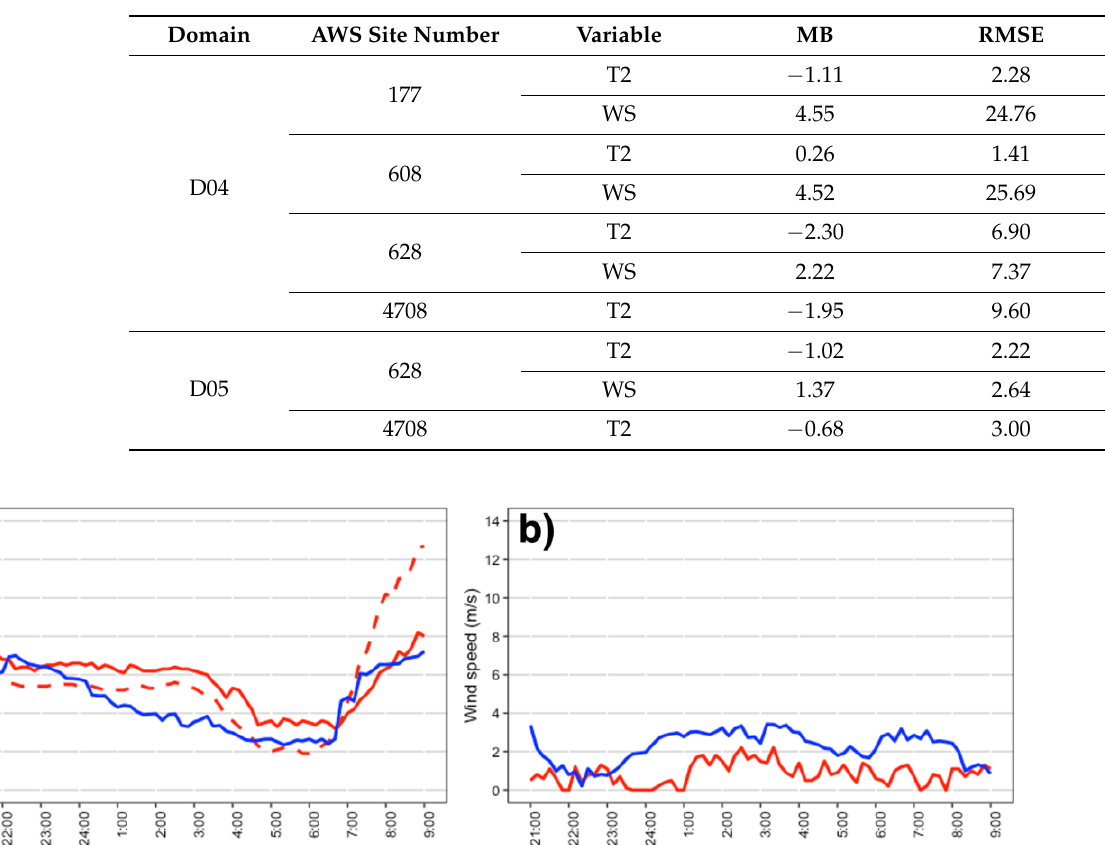
Table 4. Performance of WRF–LES simulation for Case 2.